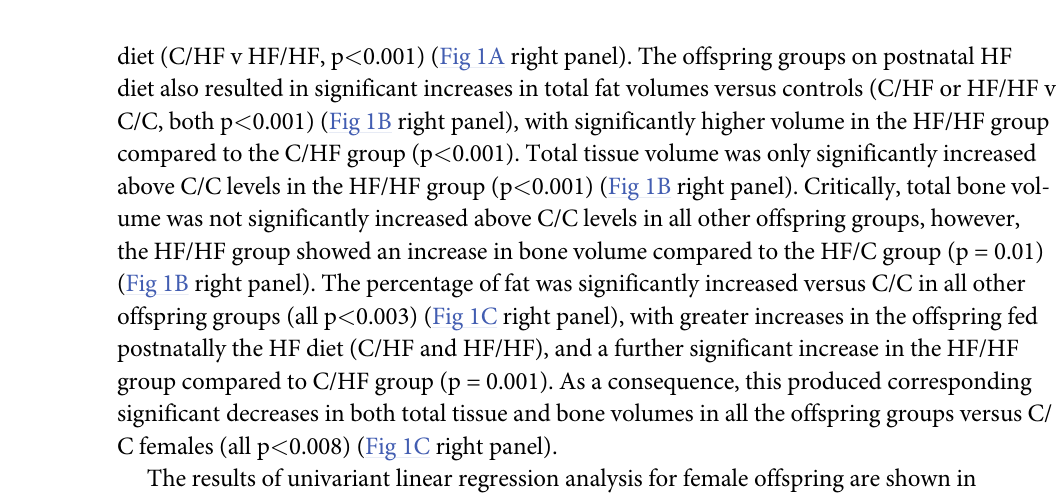
diet (C/HF v HF/HF, p < 0.001) (Fig 1A right panel). The offspring groups on postnatal HF diet also resulted in significant increases in total fat volumes versus controls (C/HF or HF/HF v C/C, both p < 0.001) (Fig 1B right panel), with significantly higher volume in the HF/HF group compared to the C/HF group (p < 0.001). Total tissue volume was only significantly increased above C/C levels in the HF/HF group (p < 0.001) (Fig 1B right panel). Critically, total bone vol- ume was not significantly increased above C/C levels in all other offspring groups, however, the HF/HF group showed an increase in bone volume compared to the HF/C group (p = 0.01) (Fig 1B right panel). The percentage of fat was significantly increased versus C/C in all other offspring groups (all p < 0.003) (Fig 1C right panel), with greater increases in the offspring fed postnatally the HF diet (C/HF and HF/HF), and a further significant increase in the HF/HF group compared to C/HF group (p = 0.001). As a consequence, this produced corresponding significant decreases in both total tissue and bone volumes in all the offspring groups versus C/ C females (all p < 0.008) (Fig 1C right panel). The results of univariant linear regression analysis for female offspring are shown in Table 1B. Body mass and volume parameters were significantly correlated with expression lev- els of MGP , O CN , Ggcx and Vkor . Multivariant analysis of these parameters showed a signifi- cant correlation with MGP , OCN , Ggcx and Vkor (with or without the addition of maternal and offspring diets). Periostin only showed significant correlations with multivariant analysis with maternal diet (Table 1B).